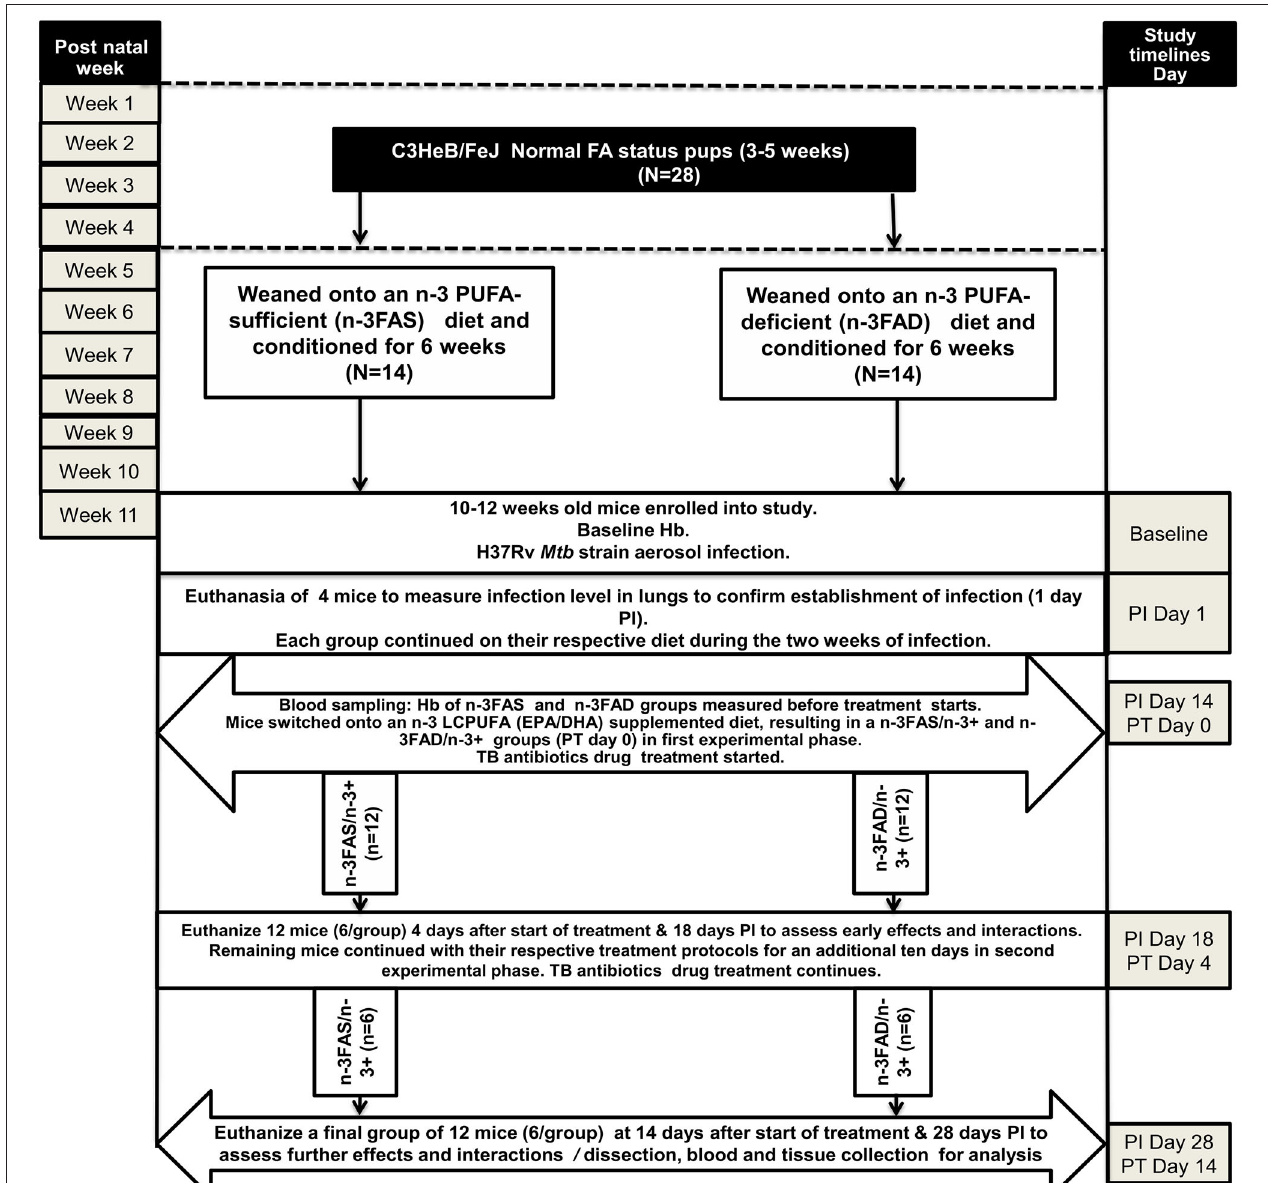
FIGURE 1 | Experimental design of the study. EPA, eicosapentaenoic acid; DHA, docosahexaenoic acid; FA: fatty acid; N: number of mice; n-PUFA: omega-3 polyunsaturated fatty acid; n-LCPUFA: omega-3 long-chain polyunsaturated fatty acid; PT, posttreatment; PI, postinfection; n-3FAS, omega-3 fatty acid-sufficient; n-3FAD, omega-3 fatty acid-deficient; n-3FAS/n-3 + : omega-3 fatty acid-sufficient on EPA/DHA supplemented diet; n-3FAD/n-3 + : omega-3 fatty acid-deficient on EPA/DHA supplemented diet.